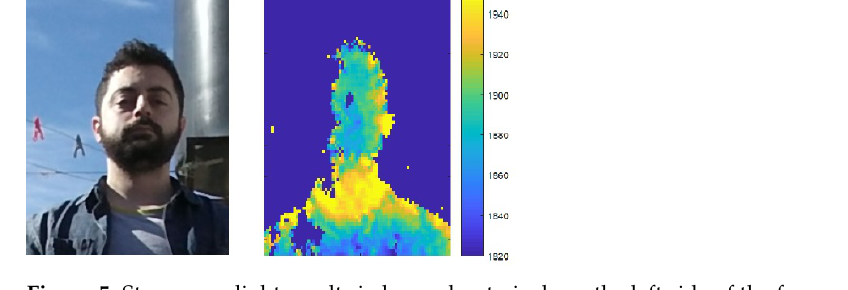
Figure 5. Strong sun light results in burned out pixels on the left side of the face. Across the sequence of depth images produced by the depth-cameras, noise is ex- pressed as inaccuracy and inconsistency of the estimated depth. It can be considered as either varying spatially or varying temporally at a pixel. Axial noise is the temporal fluctu- ation of depth values at a pixel across multiple frames (see Figure 6). It has been shown Figure 7). The source of this behavior may be the decrease in amplitude of the projected structured light cameras.